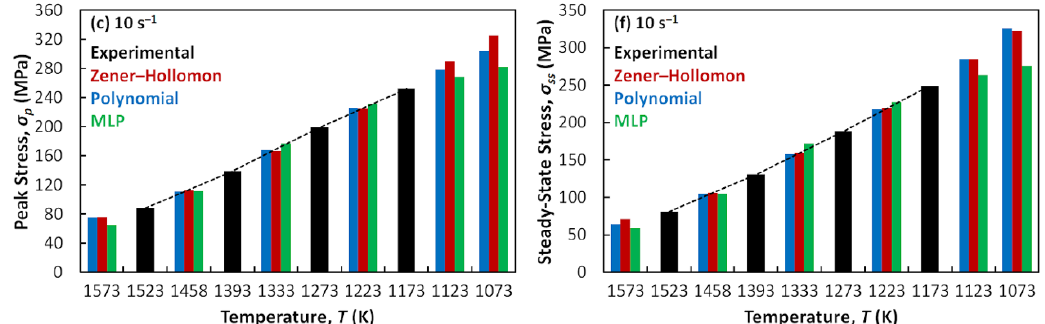
Figure 7. Peak and steady-state stress prediction inside and outside of the experimental conditions. ( a , d ) A strain rate of 0.01 s − 1 ; ( b , e ) a strain rate of 0.3 s − 1 ; ( c , f ) a strain rate of 10 s − 1 . Black columns—experimental values; red columns—values predicted via the Zener–Hollomon approach; blue columns—values predicted via the multivariate polynomial approach; and green columns—values predicted via the multi-layer perceptron approach.